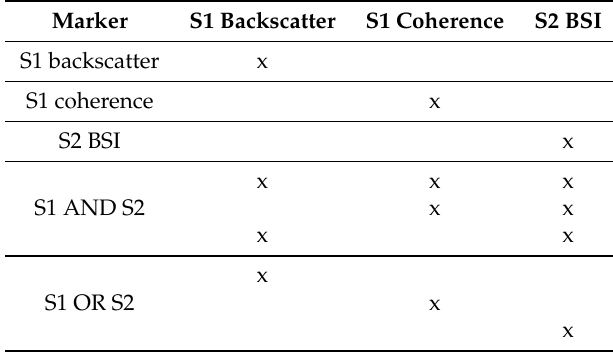
Table 1. Satellite markers and their combination. S1 AND S2 corresponds to the logical AND where the parcel should be marked by S1 (either S1 backscatter or S1 coherence) and S2 at the same time. S1 OR S2 corresponds to the logical OR where the parcel should be marked by at least one of the